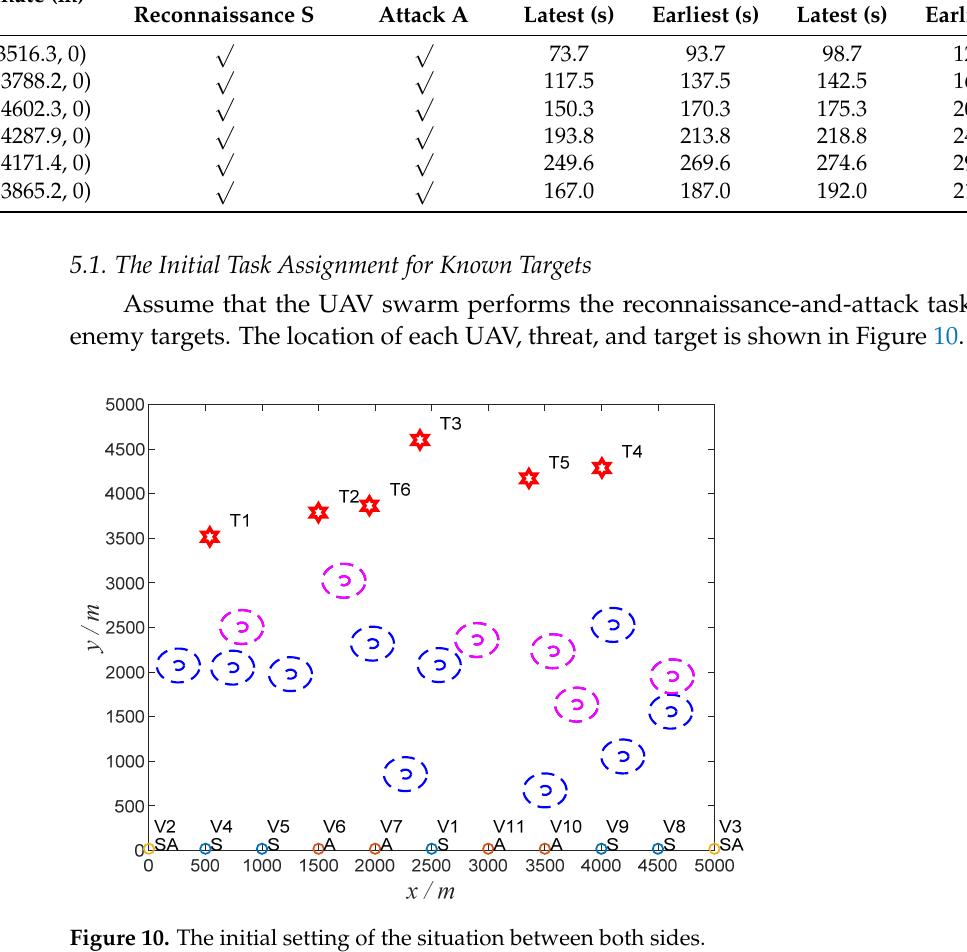
Figure 10. The initial setting of the situation between both sides. Purple threats represent known threats, and blue threats represent unknown ones, all of which the coordinates are randomly generated. The targets are marked with “T”; Each UAV is marked with “V”, where “S” represents the reconnaissance UAV, “A” rep- resents the attack UAV, and “SA” represents the reconnaissance–attack UAV. In the simulation, the maximum value of the reconnaissance subtask is set at 100, the maximum value of the attack subtask is set at 150, and the attenuation factor λ is set at 0.9. Adopting the designed UAV swarm cooperative dynamic task assignment approach, the sequential task assignment results for known targets are shown in Table 5. The task execution plan of each UAV is expressed in the format of (Target, Subtask type, Start time (s), Winning bidding value). Table 5. The task assignment of the UAV swarm. UAV